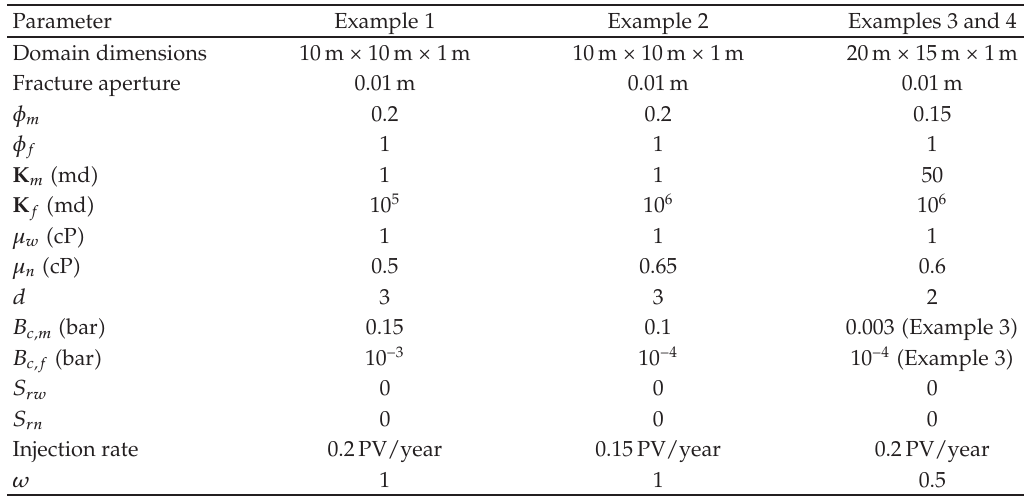
Table 1: Relevant data for Examples